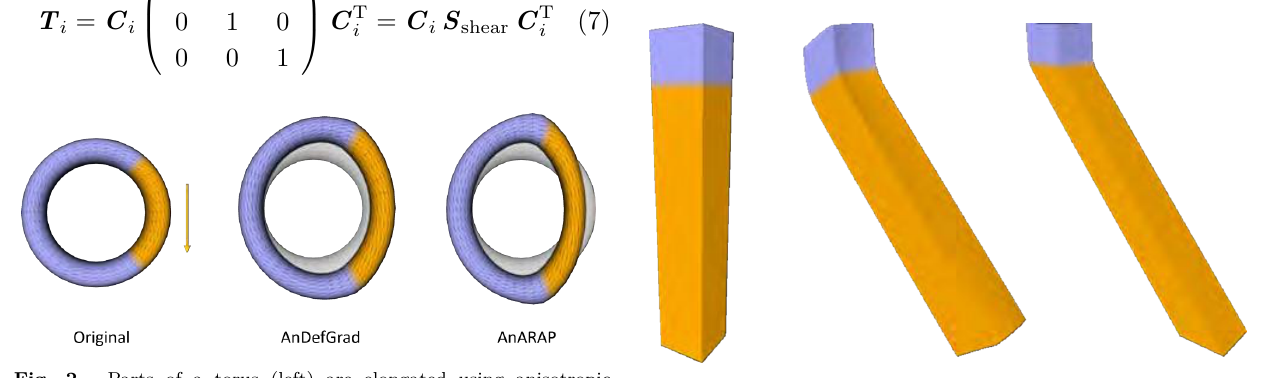
The original geometry (left) is sheared using AnARAP (middle) as well as AnDefGrad (right) deformations. The organic appearance of ARAP is visible. The modified deformation gradient method gives more control. The orange regions are involved in the deformation while the blue ones are